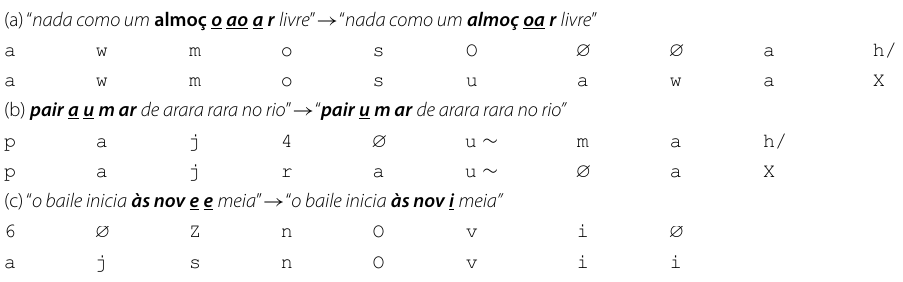
Word boundary losses, typically present in spoken language rather than in text, are represented by the empty set symbol ( ∅ ), as well as deletion or addition of phonetic tokens that can be later merged into one ( /u ∼ m → /u ∼ ) or split into two or more ( /6/ /Z/ → /a/ /j/ /s/ ),